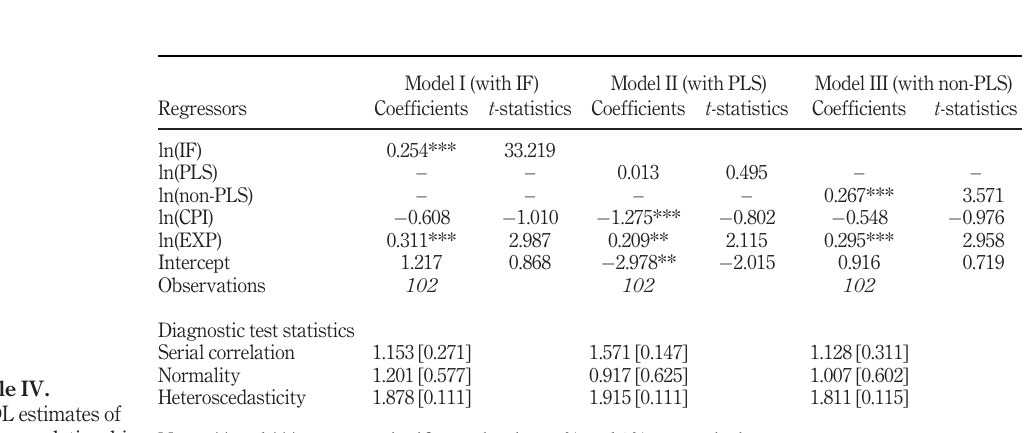
Table III. Results of bounds test